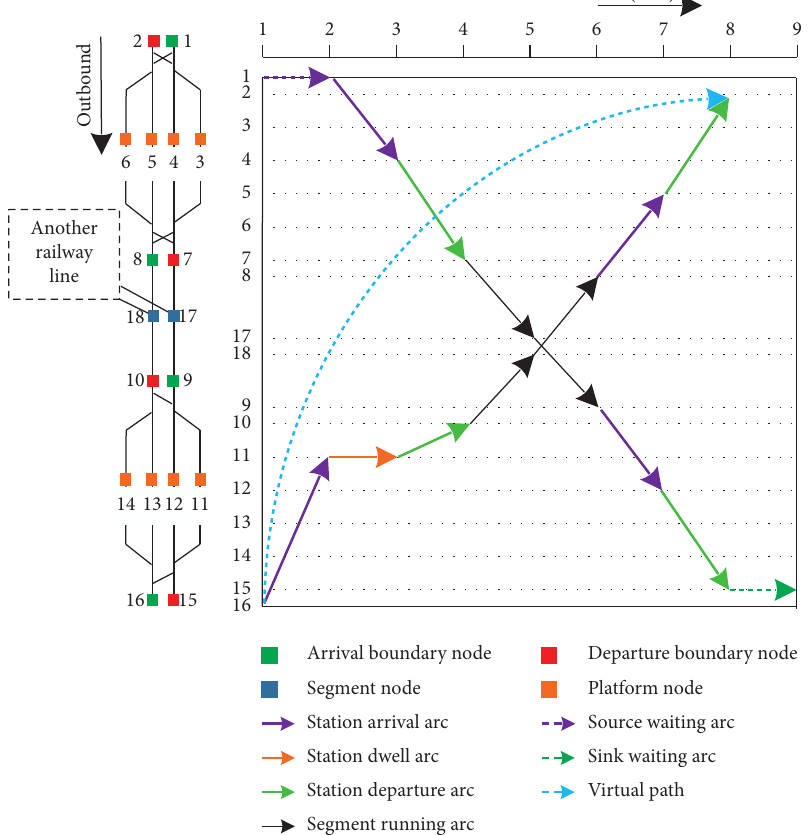
Figure 3: Space-time arc in the TPST network. Table 1: Attributes of train available arcs in the